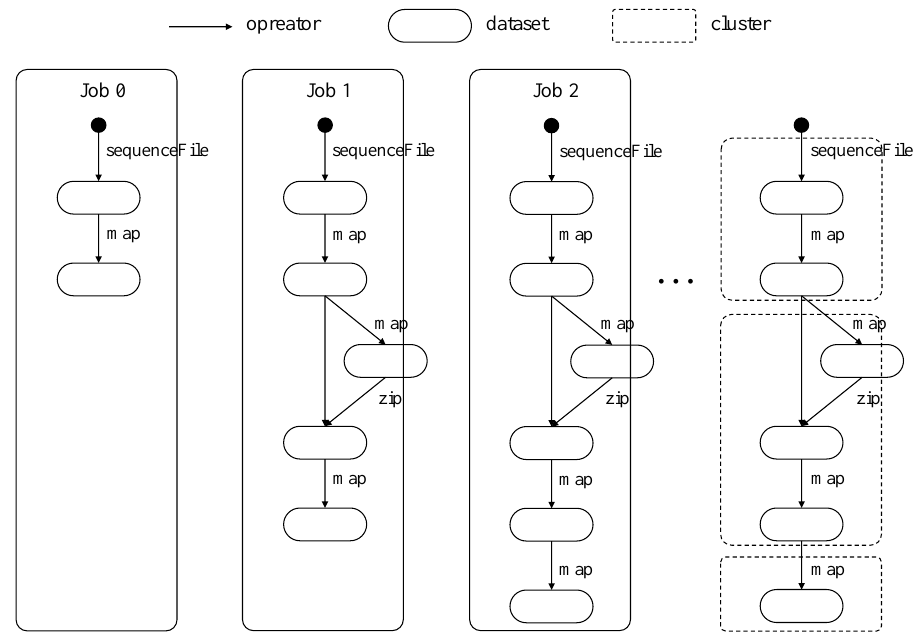
Figure 4. Part of KMeans’s job directed acyclic graphs (DAGs) and example of DAG clustering.